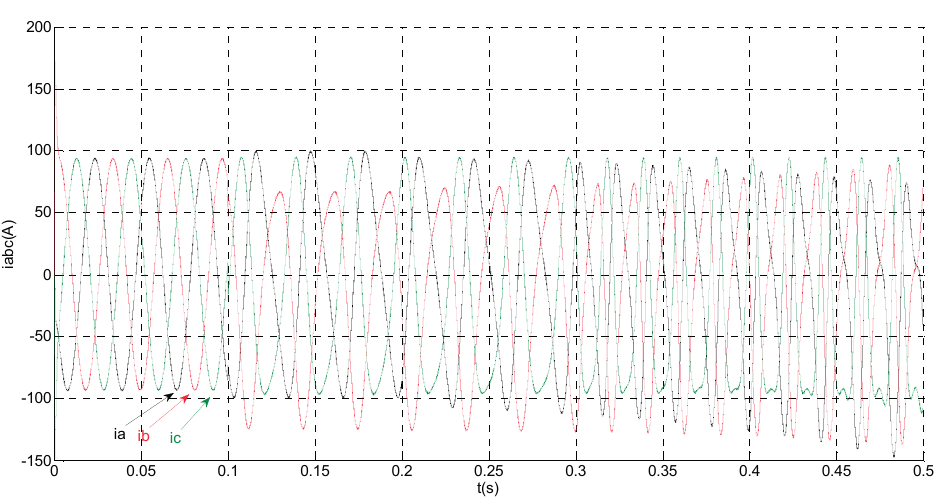
Figure 17. Simulation result of electromagnetic torque.